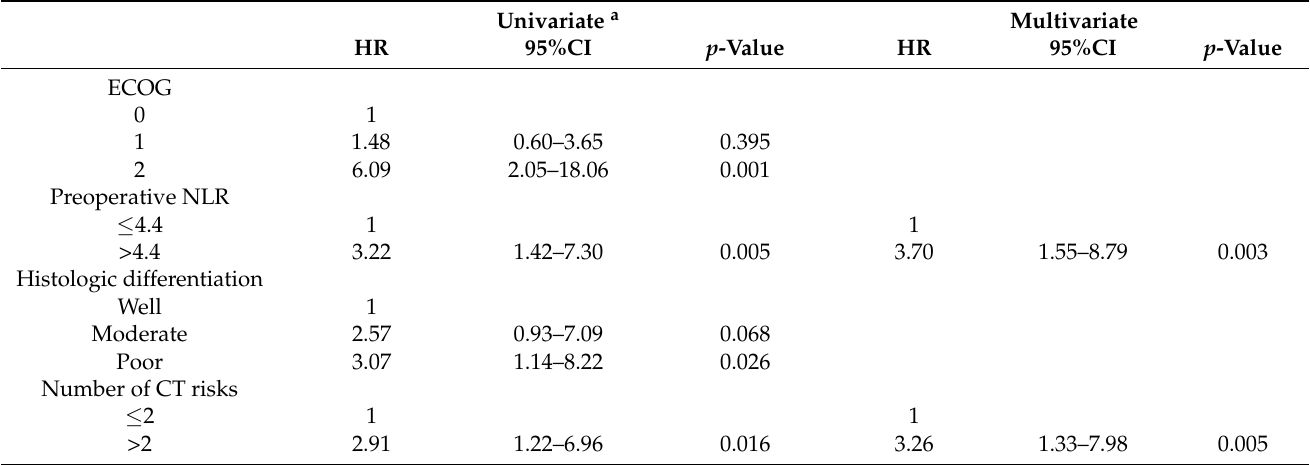
Table 3. Univariate and multivariate analyses of preoperative factors on overall survival by Cox regression. Univariate a Multivariate HR 95%CI p -Value HR 95%CI p -Value